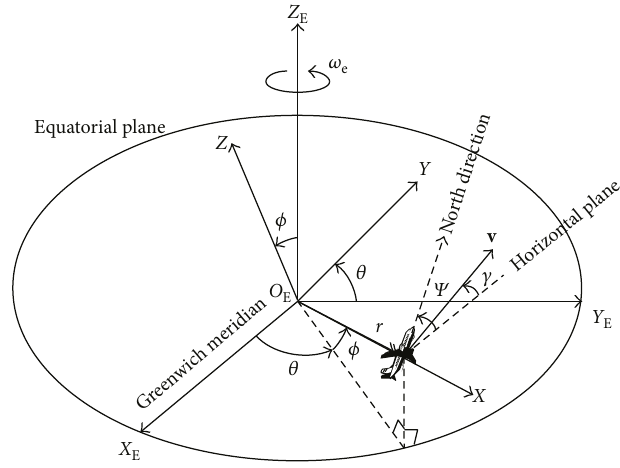
Figure 1: Geometric sketch of reentry fl